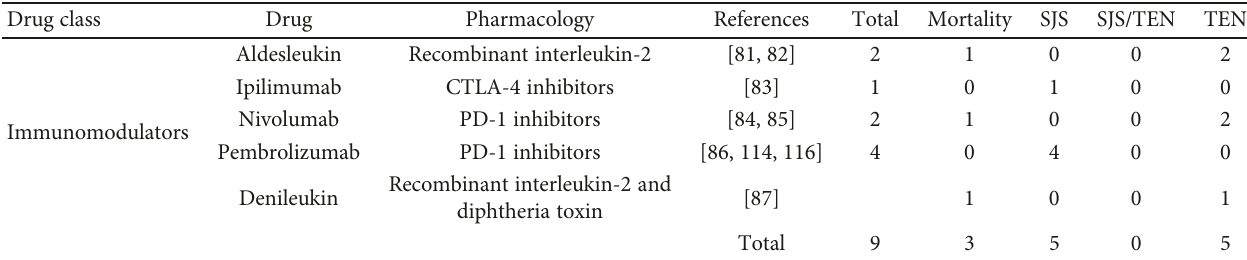
Table 3: Anticancer immune therapy-related adverse drug reactions from the English literature (year: 1950 –